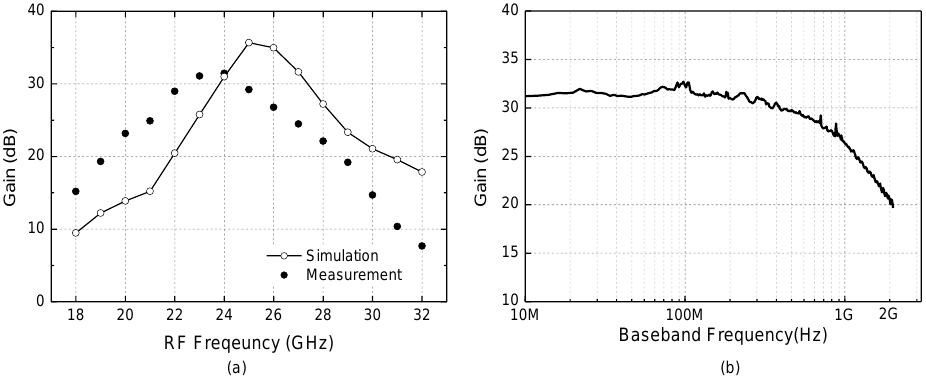
Figure 11. Frequency response characteristics. ( a ) Gain versus RF frequency; ( b ) Gain versus baseband frequency.